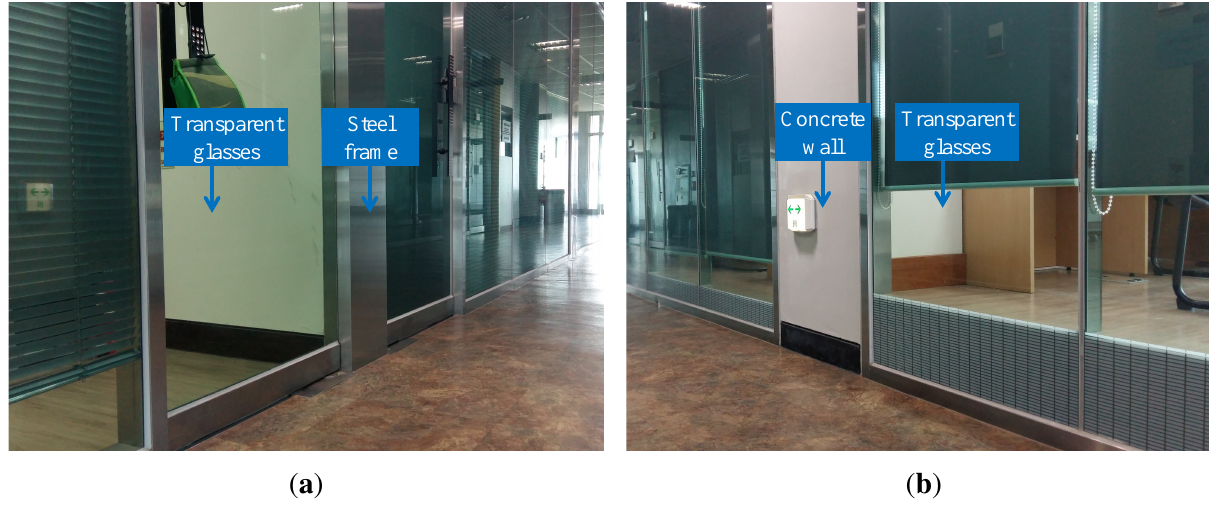
Figure 11. Snapshots of Dataset 3. Some parts of the wall are made of transparent glass. However, parts of the wall seen within the field of view consist of a steel frame or a concrete wall. ( a ) Steel frame with transparent glasses; ( b ) concrete wall with transparent